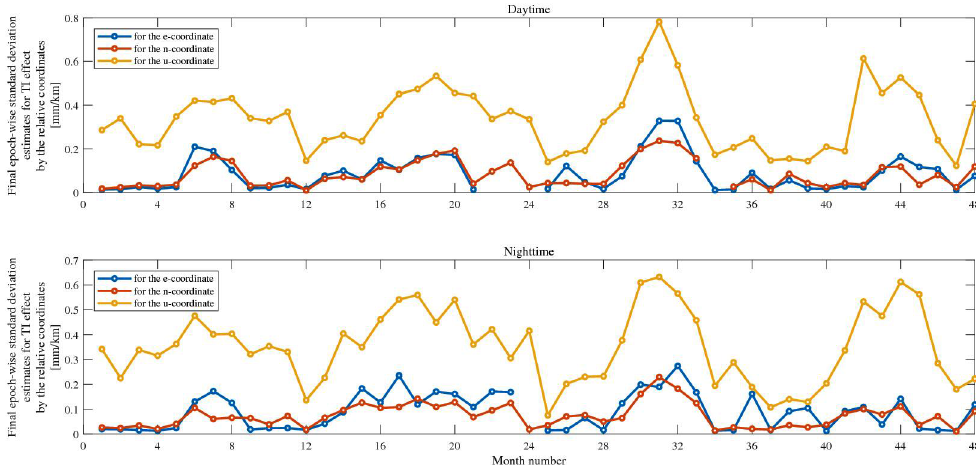
Figure 5. Final epoch-wise standard deviation estimates by the relative coordinates ( e , n and u ) for the joint effect of TI, obtained for the daytime and the nighttime